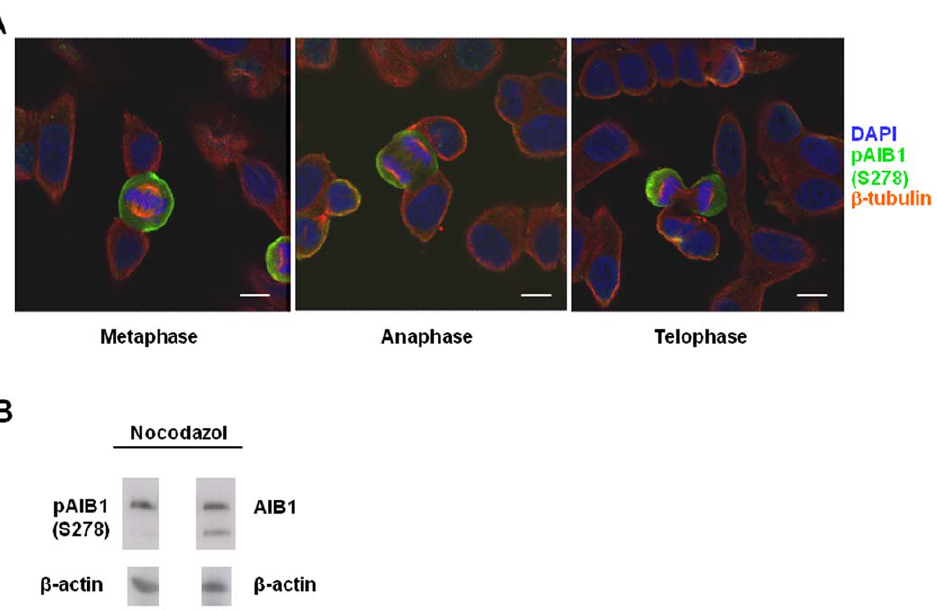
Figure 10. Phospho-specific antibodies (pAIB1) confirm that AIB1 is phosphorylated on Ser728 exclusively during mitosis. (A) Confocal microscopy analysis of an asynchonous culture of MCF-7 cells stained with DAPI (blue), anti-pAIB1(S728) (Alexa Fluor 488) and anti- b -tubulin (Alexa Fluor 633) to reveal the mitotic spindle. Scale bar: 10 m m. Only mitotic cells stain positively with pAIB1(S728) antibodies and suggest that pAIB1(S728) is excluded from chromatin. (B) Western blot analysis of MCF-7 cells arrested at mitosis with nocodazole. Cell lysates were probed with the indicated antibodies, revealing that anti-pAIB1(S728) antibodies detect exclusively the slower electrophoretic mobility band.